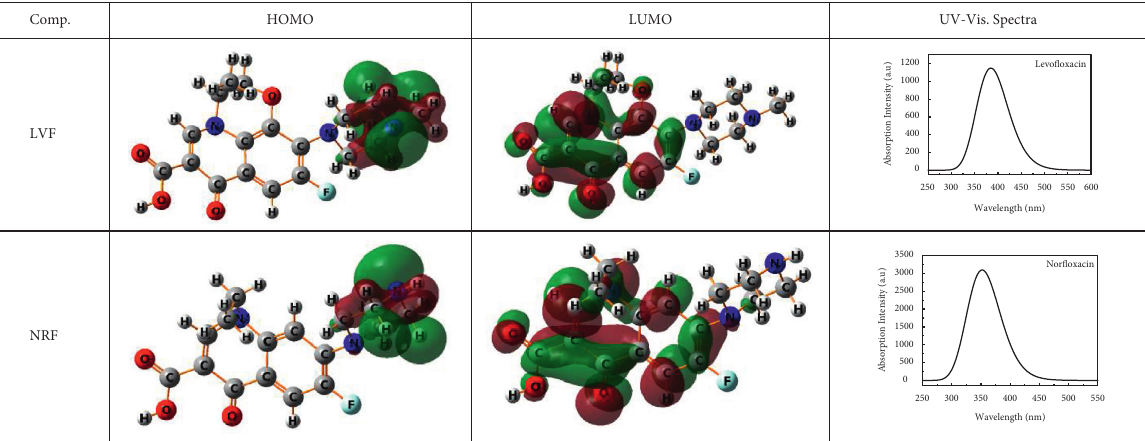
Figure 10: HOMO-LUMO structures and UV/Vis spectra of LVF and NRF determined using